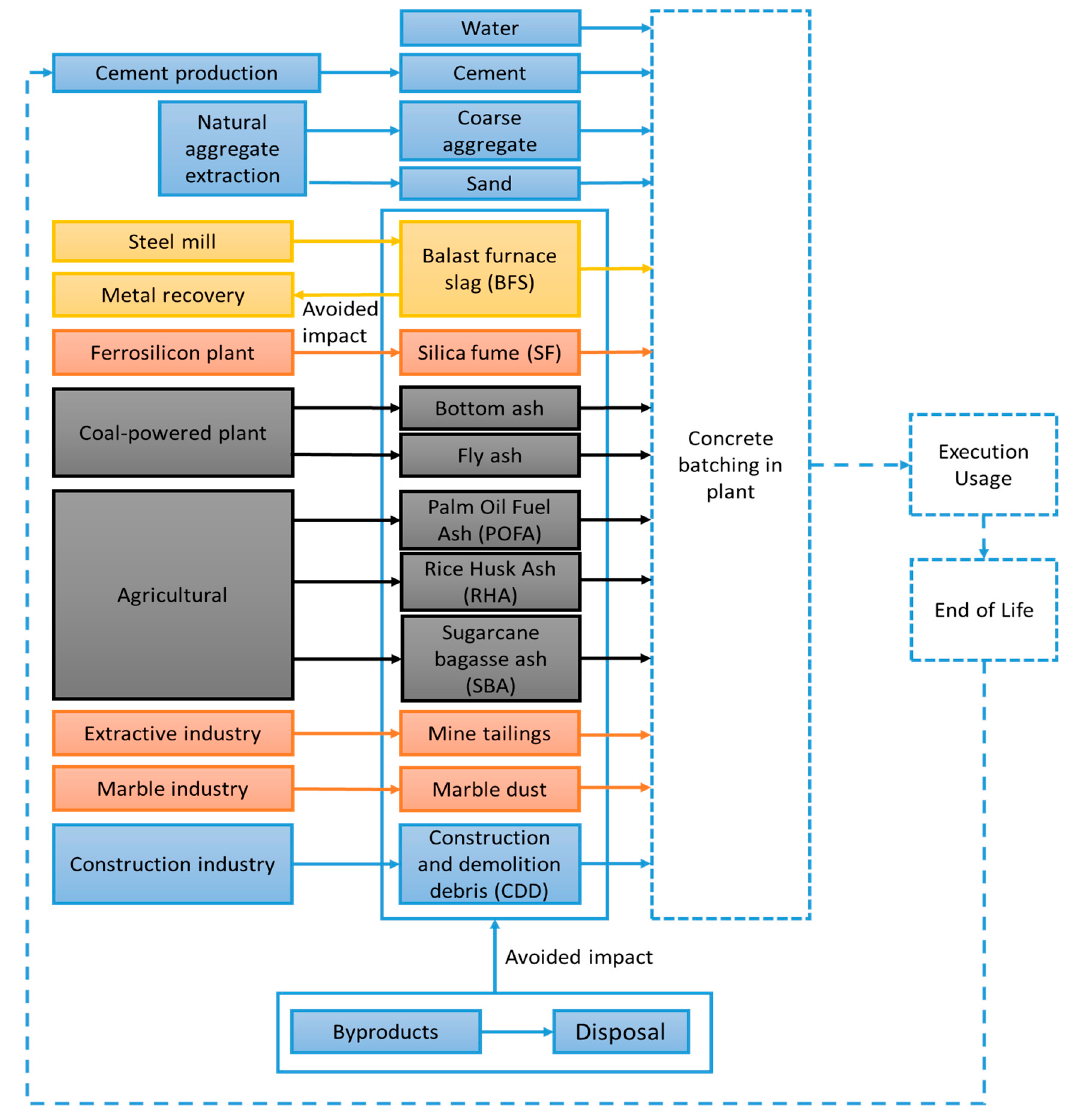
Figure 13. Cradle-to-gate life cycle assessment (LCA): studied system boundaries of the concretes (plain line—included processes; dashed line—non-included processes) [111] .